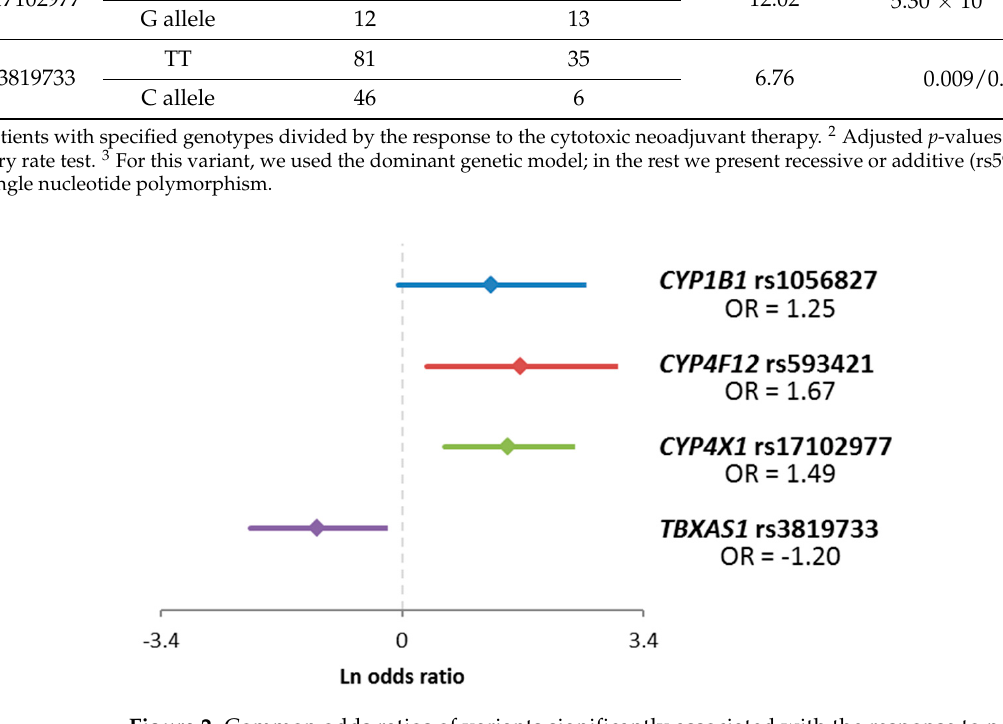
Figure 2. Common odds ratios of variants significantly associated with the response to neoadjuvant chemotherapy. OR = odds ratio.